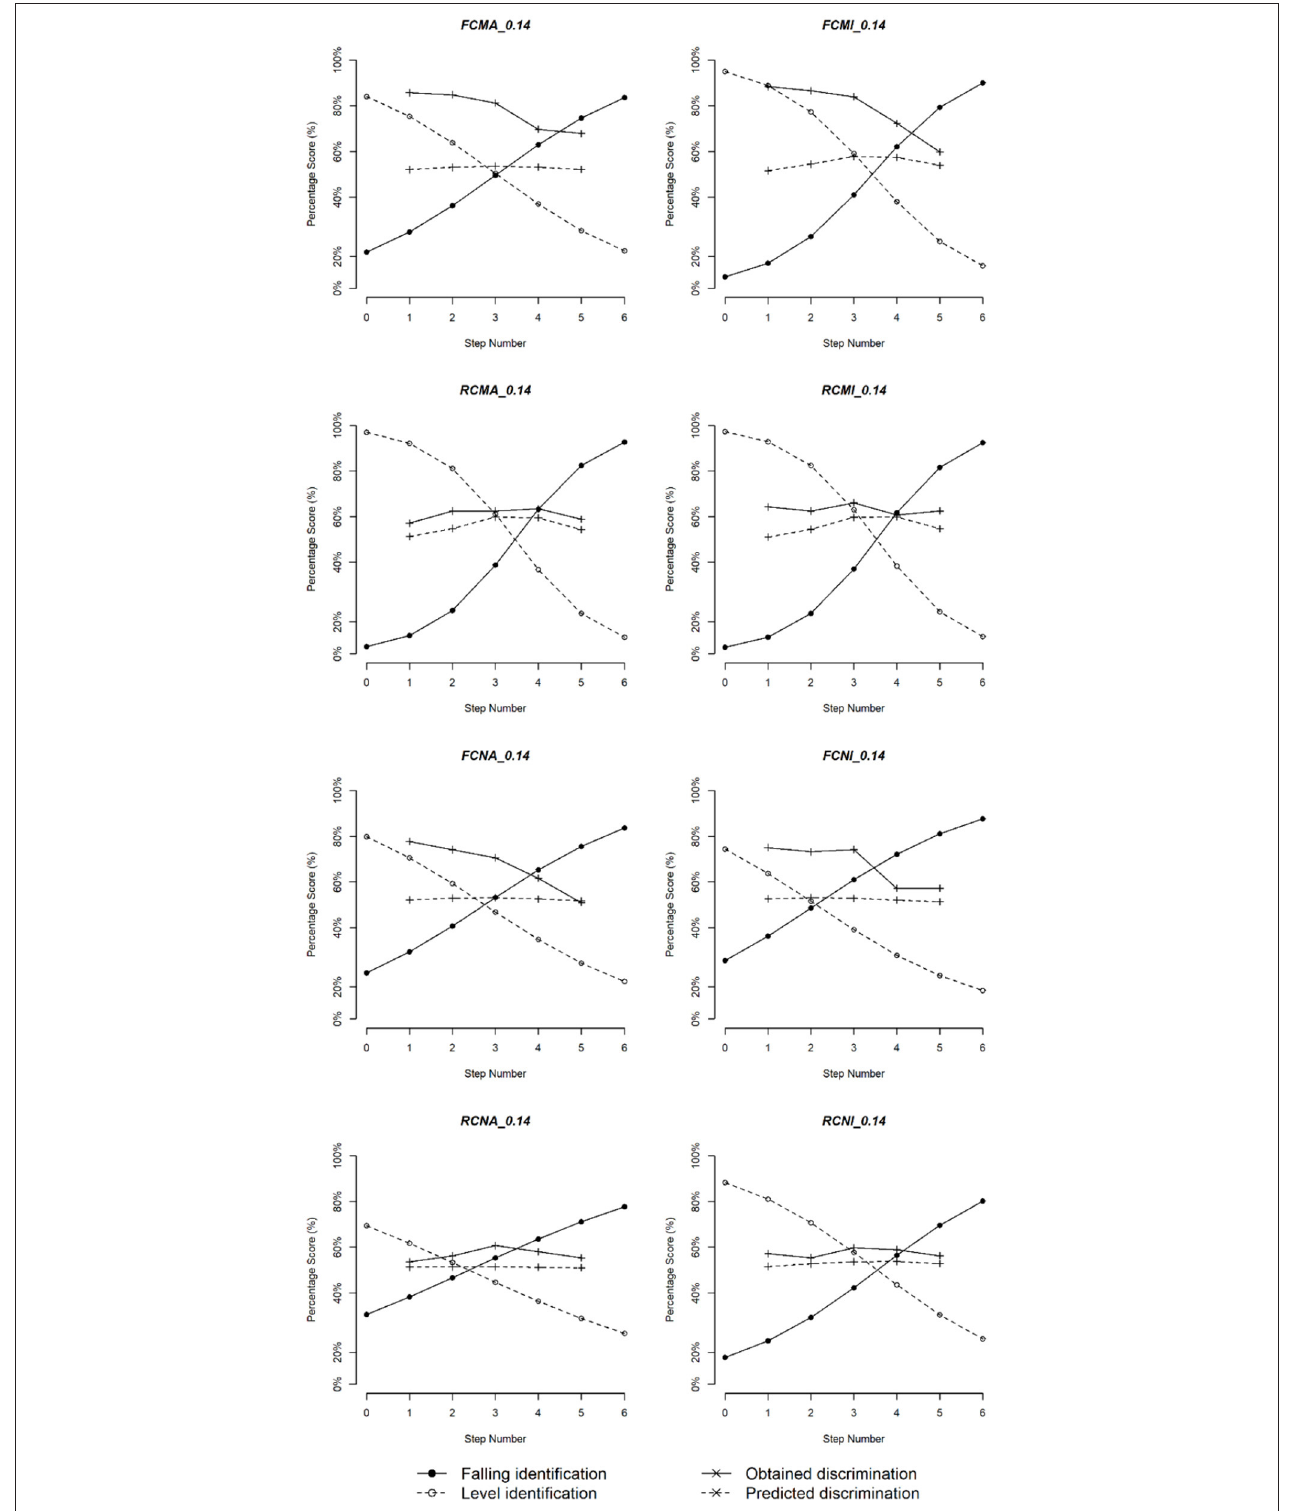
FIGURE 7 | Logistic identification functions and discrimination curves for eight subgroups of Cantonese speakers with duration 140ms.